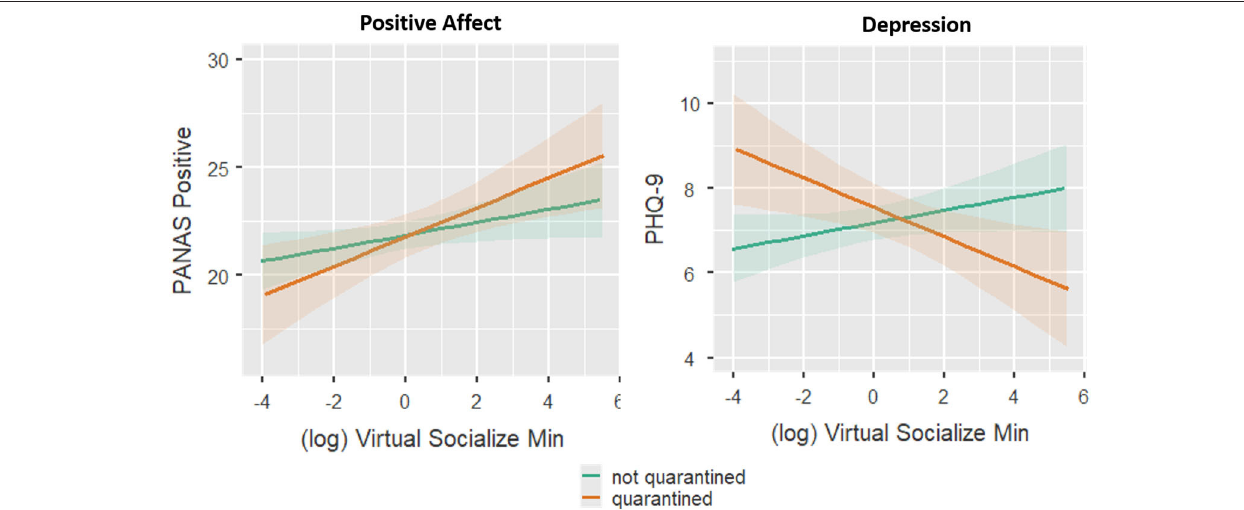
FIGURE 4 | Effects of minutes spent socializing virtually and quarantine on positive affect and depression symptomology (Model 4). Minutes spent socializing virtually is log 2 transformed (see text) and then mean centered (i.e., 0 represents the mean of the log transformed minutes across all observations). Shading around the lines show the 95% confidence interval.